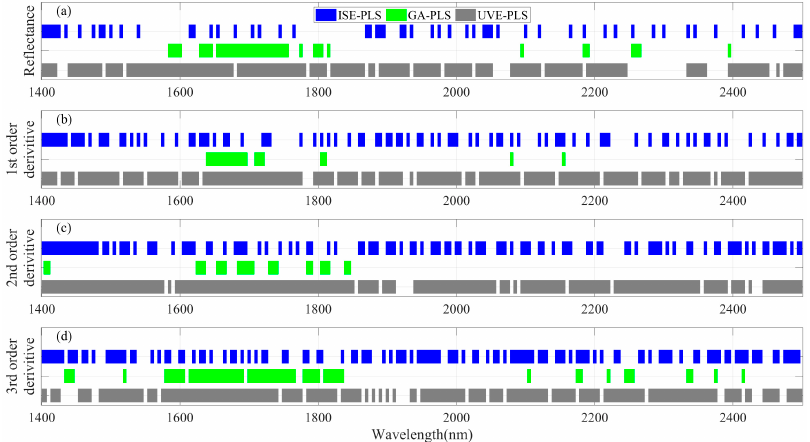
Figure 3. Distribution of bands selected with different band-selection methods for LNC estimation from spectra within 1400–2500 nm. ( a ) Reflectance. ( b ) The 1st-order derivative spectra. ( c ) The 2nd-order derivative. ( d ) The 3rd-order derivative. The locations of the color blocks in the Wavelength-axis represent the bands involved in different PLS (blue for ISE-PLS, green for GA-PLS, and grey for UVE-PLS) regression models.